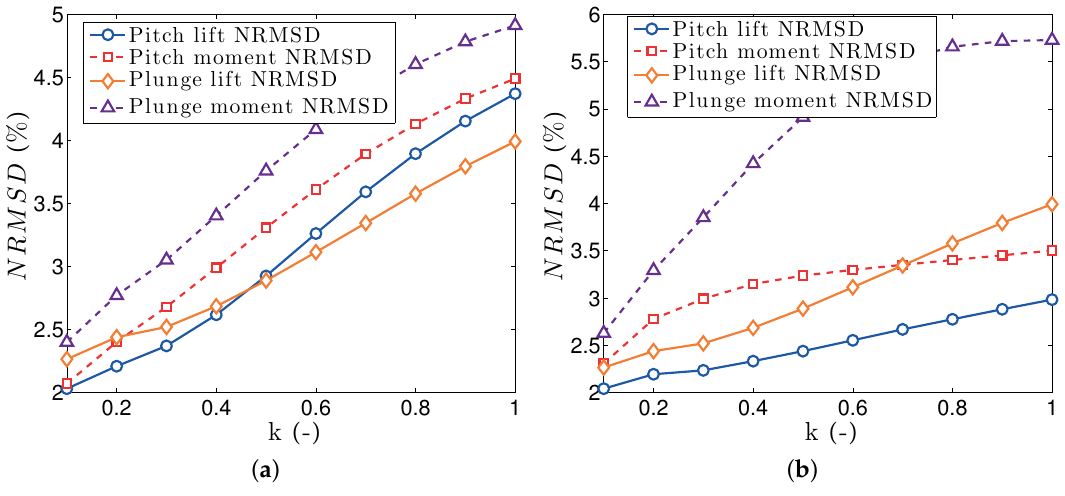
Figure 12. NRMSD between VLM and WLL aerodynamic responses for a tapered wing AR = 6 undergoing oscillations motion. ( a ) Pitch axis on root leading edge; ( b ) Pitch axis on root quarter